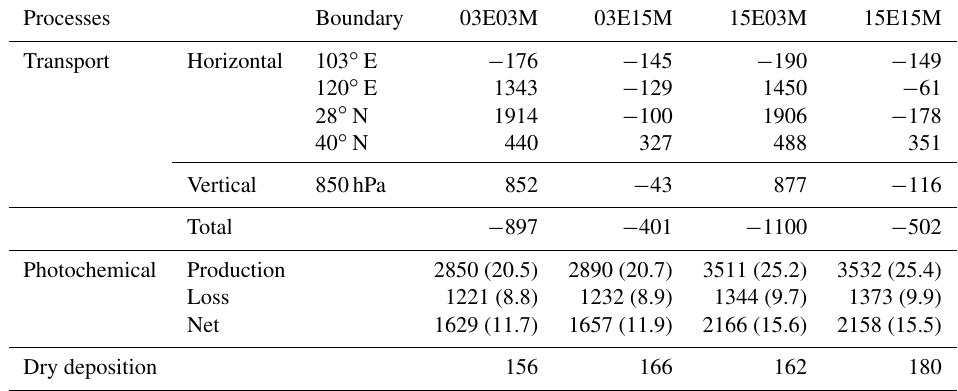
Table 4. Horizontal and vertical flux (Ggmonth − 1 ), photochemical production and loss (Ggmonth − 1 ; the numbers in the parentheses are in ppbvday − 1 ), and dry deposition (Ggmonth − 1 ) of O 3 over CEC from the surface to 850hPa based on four types of simulations. For horizontal flux, positive values indicate eastward or northward transport. For vertical fluxes, positive values indicate upward transport. “Total” refers to the sum of horizontal and vertical transport. Net photochemical O 3 production is the difference between production and loss of O 3